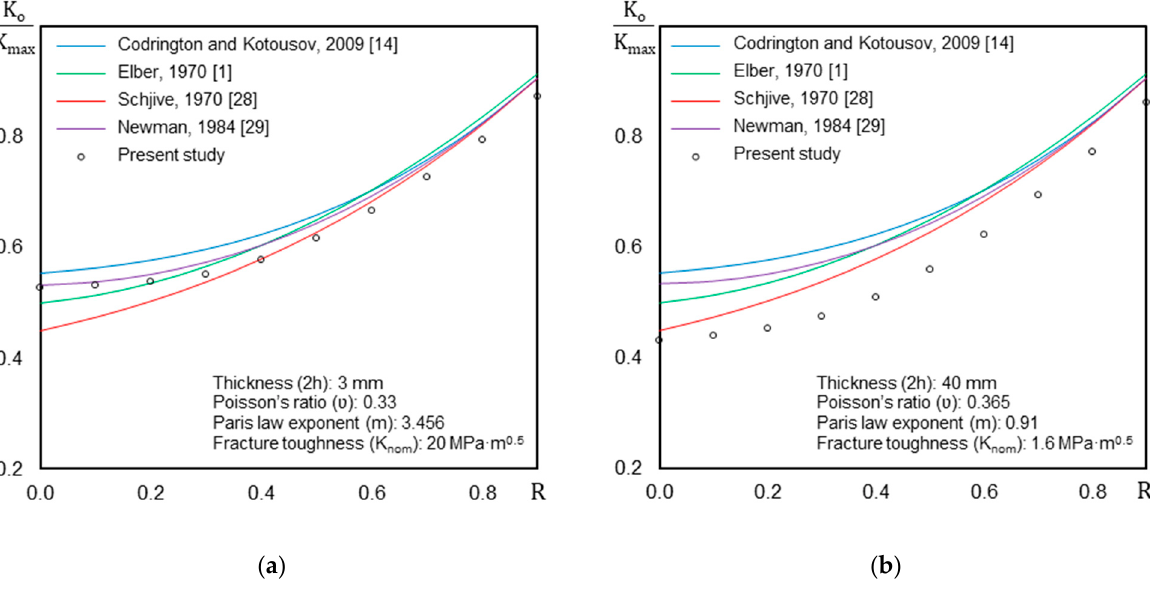
Figure 9. The ratio of the of the opening stress intensity factor to the maximum stress intensity factor as a function of the R ratio along the crack front and past published functions: ( a ) 6082-T6 aluminium alloy; ( b ) polymethyl methacrylate.